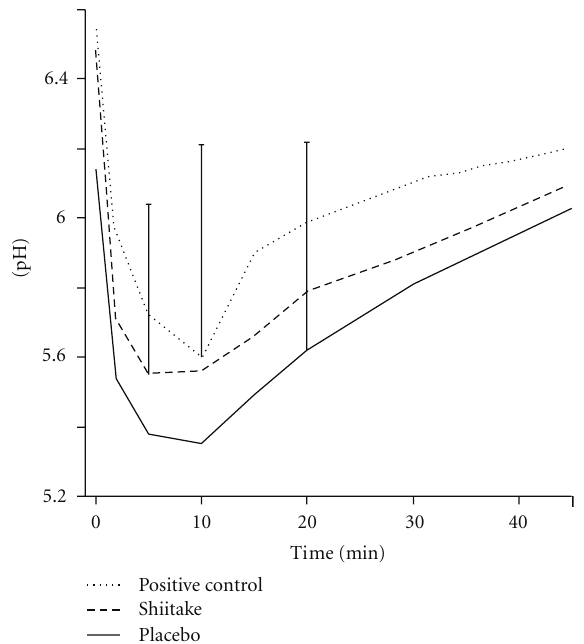
Figure 1: The changes in dental plaque pH up to 45 min after a mouth rinse with 10% sucrose for 1min. The rinse was carried out after two weeks use of a mouth rinse with a shiitake mushroom extract, a placebo, or positive control (AmF-SnF 2 ). Mean values for 30 subjects. The standard deviation for some of the time points is